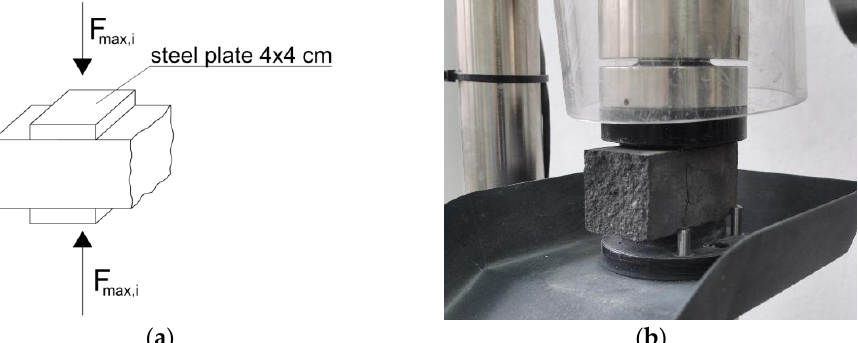
Figure 2. Determination of compression strength: ( a ) static scheme, loading, and geometry of tested specimens; ( b ) the view of the specimen ready to test.